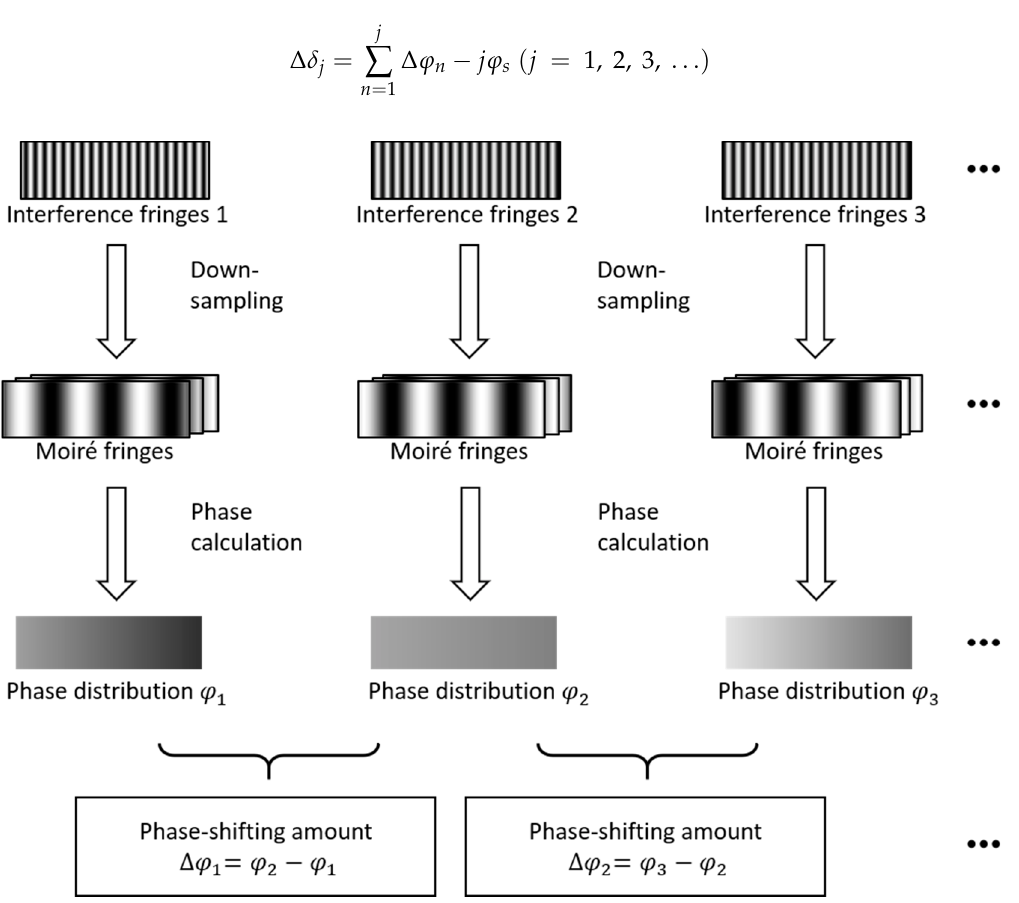
Figure 3. Principle of the sampling Moiré technique to determine the phase-shifting errors.